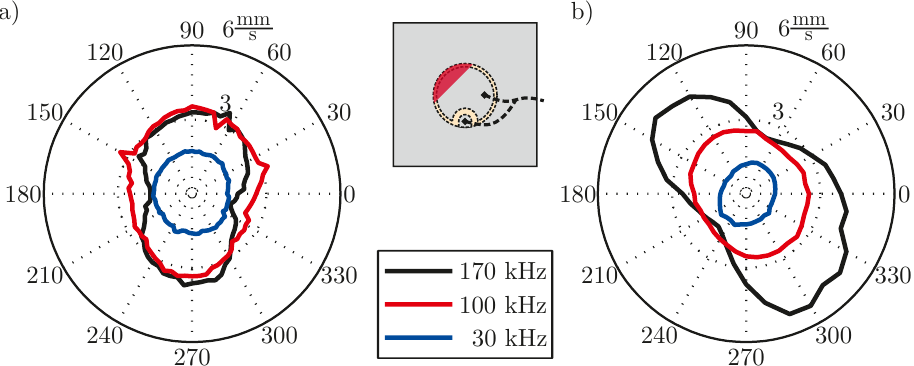
Figure 7. Polar plot of the maximum out-of-plane velocity for ( a ) a fully bonded transducer and ( b ) a 20% debonded transducer, measured at the structure on a circle around the PWAS center with a radius of 20